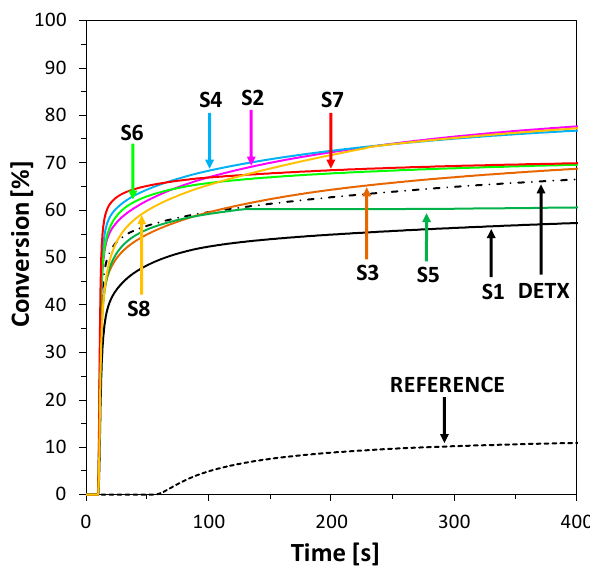
Figure 15. Polymerization rate profiles for photopolymerization of TMPTA with HIP (1 wt.%) and 2-amino-4,6-diphenyl-pyridine-3-carbonitrile derivatives (0.1 wt.%) under MPM lamp with 400–500 nm filter (intensity at the surface of sample 75 mW/cm 2 ) irradiation, calculated from photo-DSC data. The irradiation starts at t = 10 s.